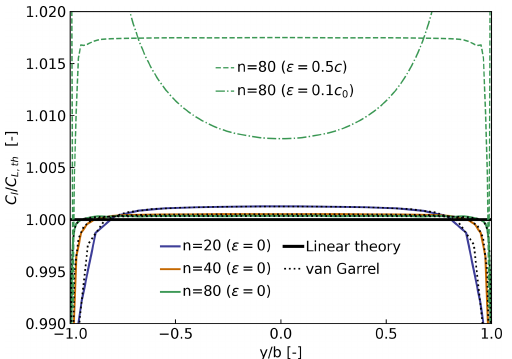
Figure 3. Lift coefficient along elliptical wing ( C l ) as predicted by two similar lifting-line implementations (OLAF and van Garrel) and the linear lifting-line theory ( C L,th ). Results for various numbers of spanwise stations ( n ) and regularization parameters ( (cid:15)